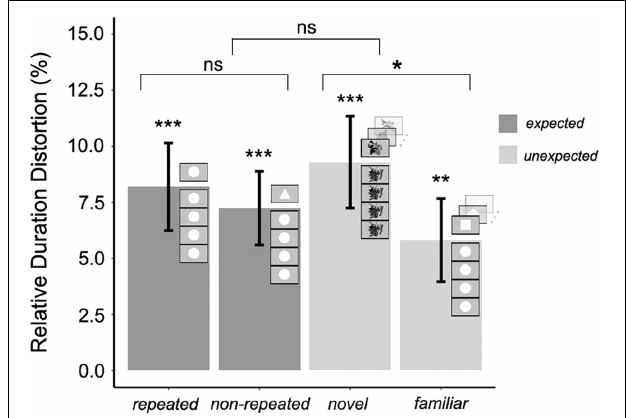
FIGURE 5 | Mean relative duration distortion for expected and unexpected target stimuli with a long timescale of stimuli presentation (Experiment 2); error bars represent the standard error of the mean. The significance of the magnitude of the oddball effect in each experimental condition (Bonferroni correction for multiple one-tailed t -tests was used; p -value was significant if p < 0.01) and the significance of the three orthogonal planned contrasts (no need for p -value correction; p -value was significant if p < 0.05) between and within expected and unexpected target stimulus conditions is shown ( ∗ p < 0.05; ∗∗ p < 0.01; ∗∗∗ p < 0.001).